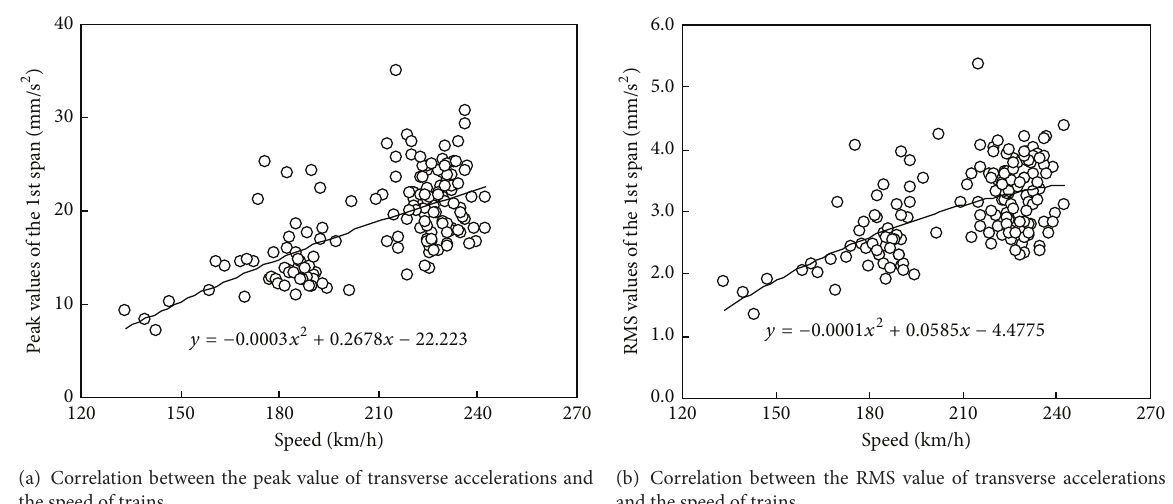
Figure 3: Correlations between the amplitude parameters of the transverse accelerations in the middle of the first main span and the speed of the